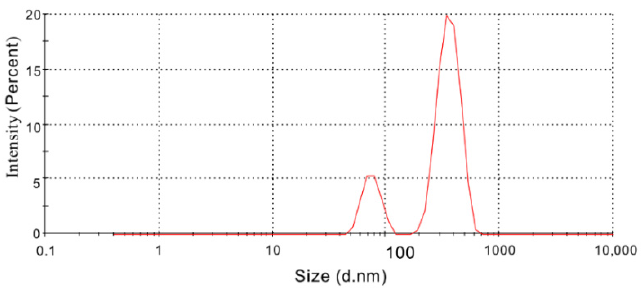
Figure 4. Bimodal particle size distribution by intensity of colloidal dispersion (2.5% PL90H:1% SO:0.5% TE).